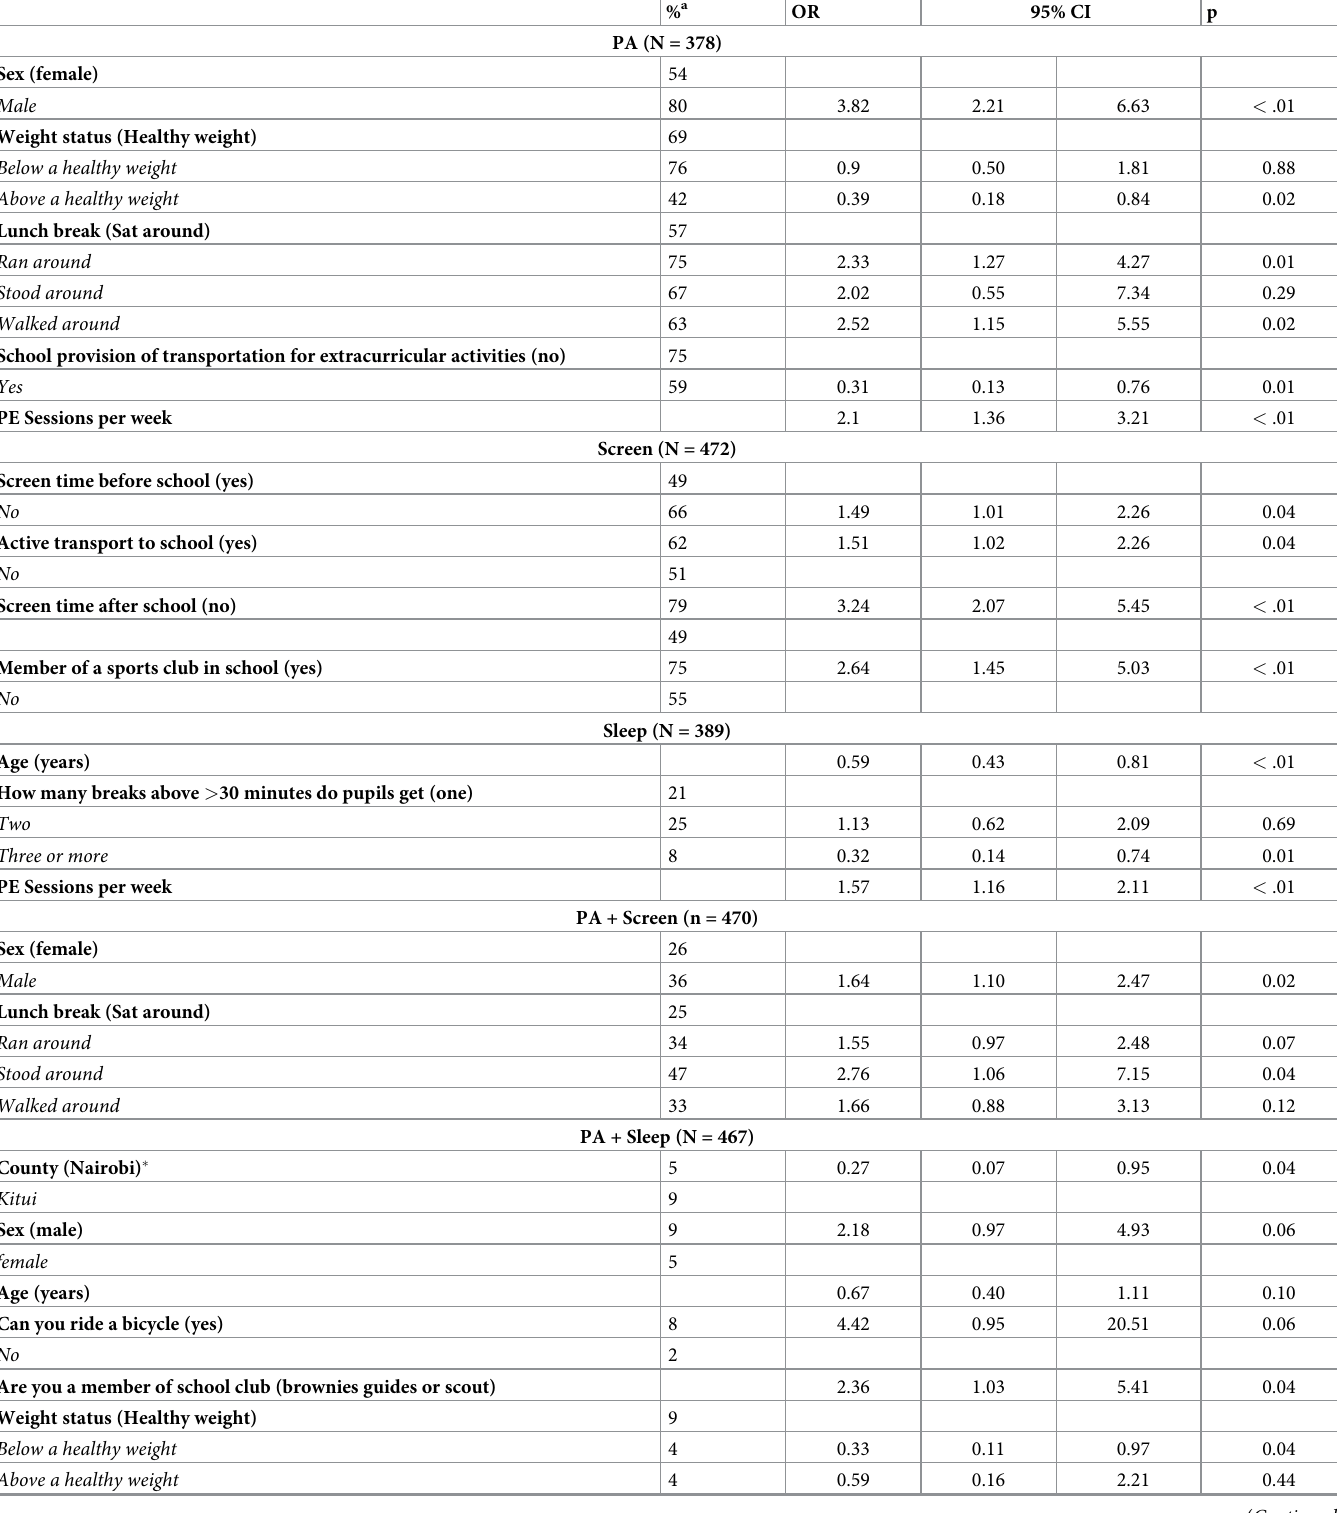
Table 2. Multi-level multivariable analysis of correlates of meeting 24-h movement